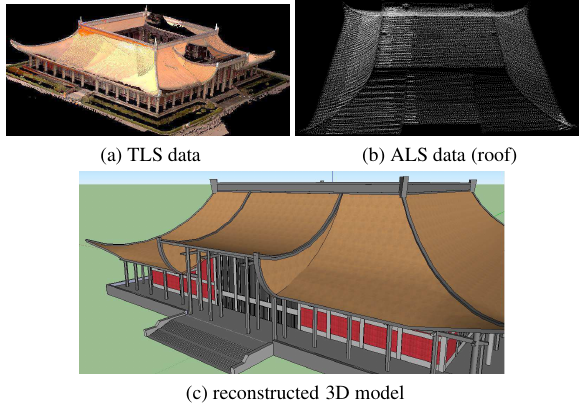
Figure 3: 3D reconstruction of Dr. Sun Yat Sen Memorial Hall of Taipei, Taiwan from LiDAR point clouds.